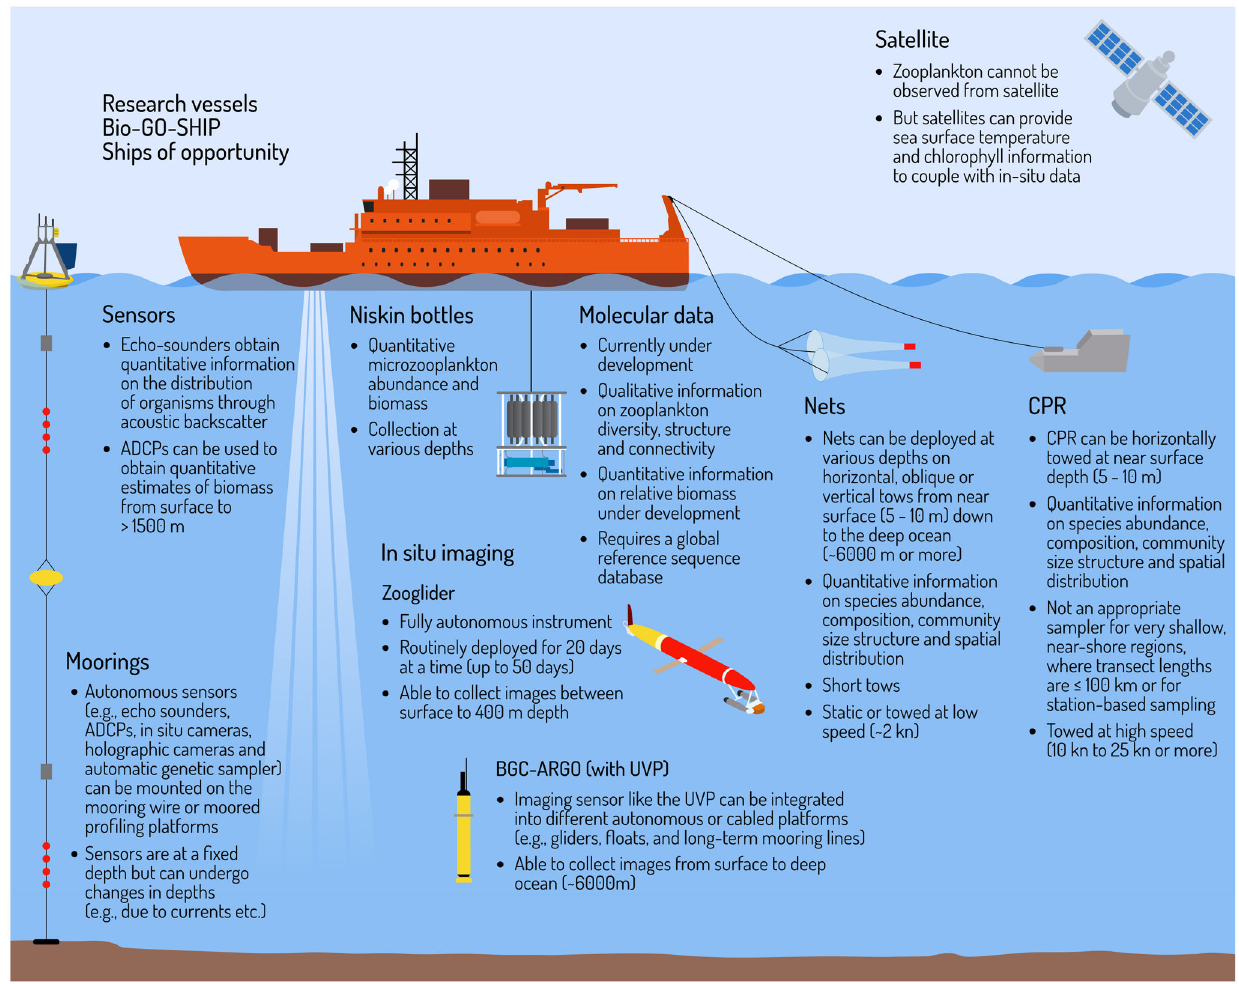
Fig. 4 | Integrating traditional zooplankton in situ sampling methods and modern sampling techniques. Traditional techniques such as Continuous Plank- ton Recorder (CPR), nets and Niskin bottles have been used to monitor zoo- planktonfordecades withgreatsuccess.However,coupling traditionaltechniques withnewermethodssuchasmoleculardata(forexample,DNA,RNAandproteins), advanced sensors, in situ imaging approaches and satellites can improve